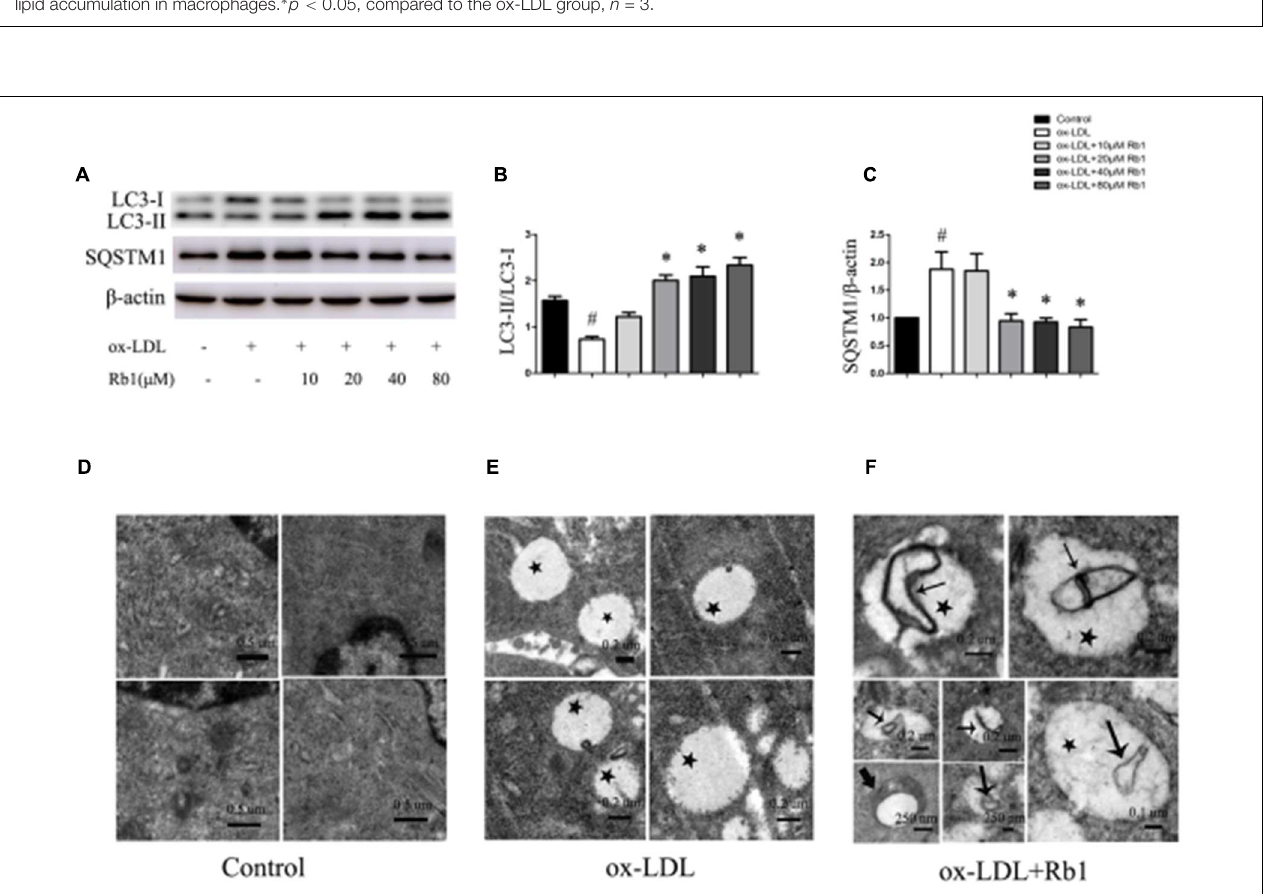
FIGURE 2 | Rb1 rescued the impaired autophagy flux in macrophage foam cells. (A) Representative western blot analysis of LC3B and SQSTM1/p62. (B) Quantification of LC3 and (C) SQSTM1/p62 expression relative to the β -actin level in different groups. Electron microscopic analysis of autophagosomes in macrophage foam cells treated with Rb1. Primary peritoneal macrophages were incubated with (D) PBS or (E) ox-LDL (100 µ g/ml) for 24 h, and further incubated with (F) Rb1 (20 µ M ) for another 24 h. Asterisks indicate lipid droplets (LDs); arrows indicate double-membrane vesicles analogous to autophagosomes (APs) in or around LDs. ∗ p < 0.05, compared to the ox-LDL group; # p < 0.05, compared to the control group, n = 3.